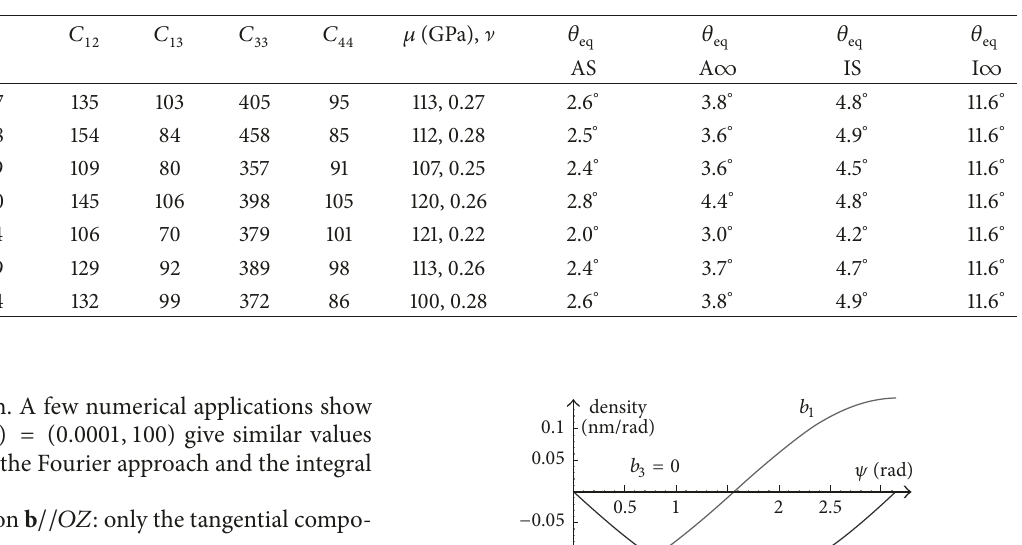
Table 1: Elastic constants of GaN. In anisotropic elasticity, the equilibrium angle 𝜃 eq of the inclined ( a + c ) TD is small, weakly depending on the existence of a free surface (columns 8 and 9). It is not the case in isotropic elasticity (columns 10 and 11). Symbols A, S and I means Anisotropy, Surface and Isotropy.